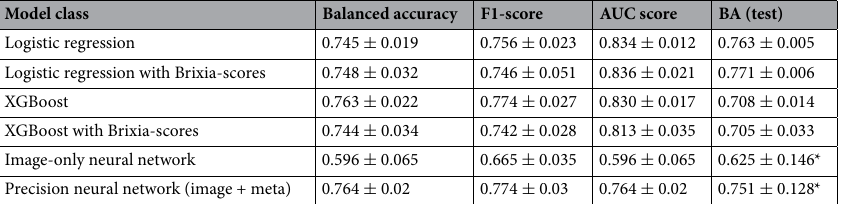
Table 2. Comparison of selected baseline models with the different input modality neural networks. All models were evaluated with population average based imputing. The selected explainable networks (logistic and XGBoost models with Brixia-scores included) are also shown in the table. The image based visual scores (Brixia-scores) do not significantly improve either generalization or model performance of the XGBoost or the logistic model. The precision network (combination of imaging and metadata) has much higher variance on the test set due to bootstrapping and it also shows that within our specific problem, slightly changing the test dataset, significantly impacts performance. In all the cases, except the neural networks, the test scores were acquired as the average outcome of the cross-validated models as opposed to bootstrapping (*) in the latter cases.